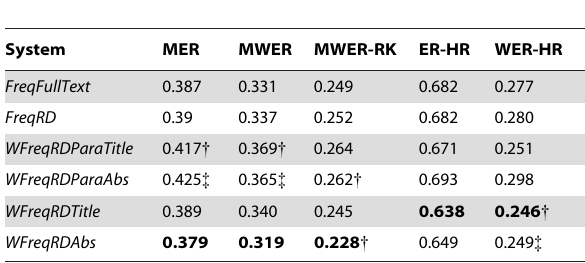
Table 2. Performance of automatic figure ranking using frequency-based centrality.